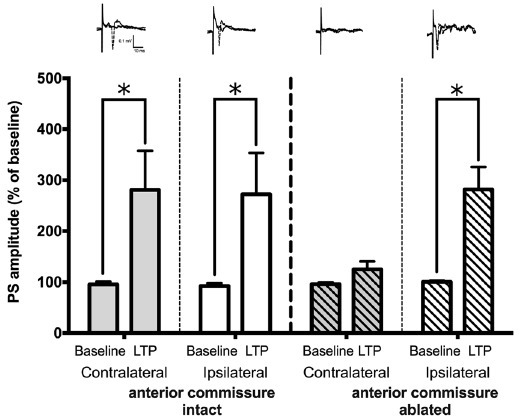
Figure 5. Both the contralateral fEPSP and HFS-LTP vanished after anterior commissure ablation. Without the anterior commissure being severed, both the ipsilateral and contralateral HFS-LTP remained intact (p = 0.0223 and 0.0194 respectively, intact). When the anterior commissure was ablated before recording, both the contralateral fEPSP and HFS-LTP vanished without any impairment in the ipsilateral HFS-LTP (Ipsilateral and contralateral, p = 0.0403 & 0.714 respectively, ablated). Each point represents the mean ± SEM of the PS